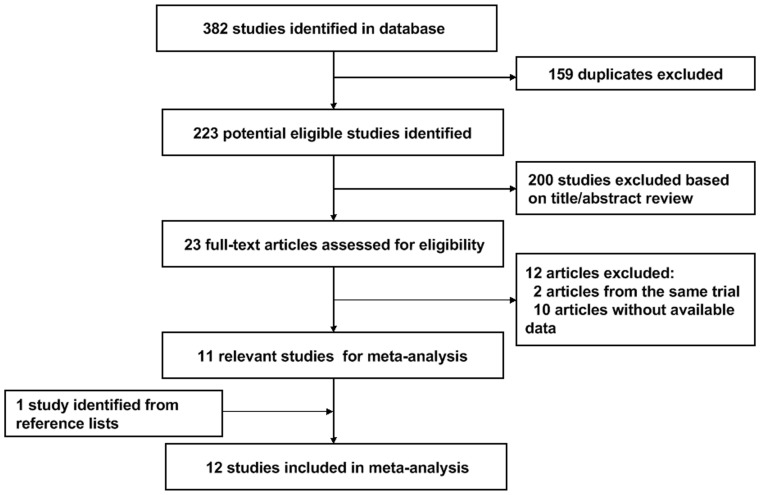
Flow diagram of screened, excluded, and analysed publications.